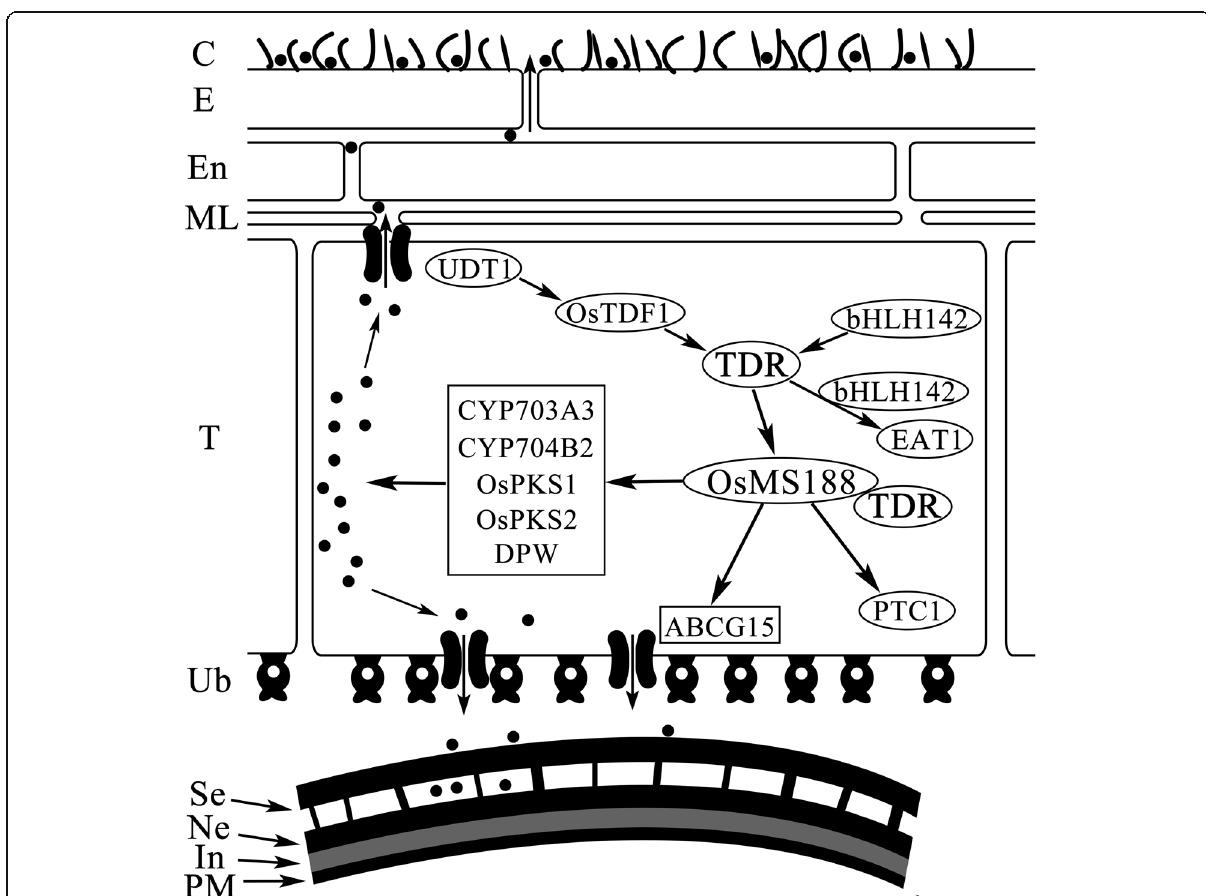
Fig. 8 Proposed model for rice tapetum-related gene regulatory network. In the genetic pathway of the rice tapetal layer, the oval circles represent transcription factors. The genes in the box represent downstream enzymes. The black arrows represent positive regulation, and the black dots represent lipid synthesis in tapetal cells. This model indicates that OsMS188 acts as a core hub to modulate tapetum development and pollen wall and cuticle formation. C, cuticle; E, epidermis; En, endothecium; In, intine; ML, middle layer; Ne, nexine; PM, plasma membrane; Se, sexine; T, tapetum; Ub, Ubisch